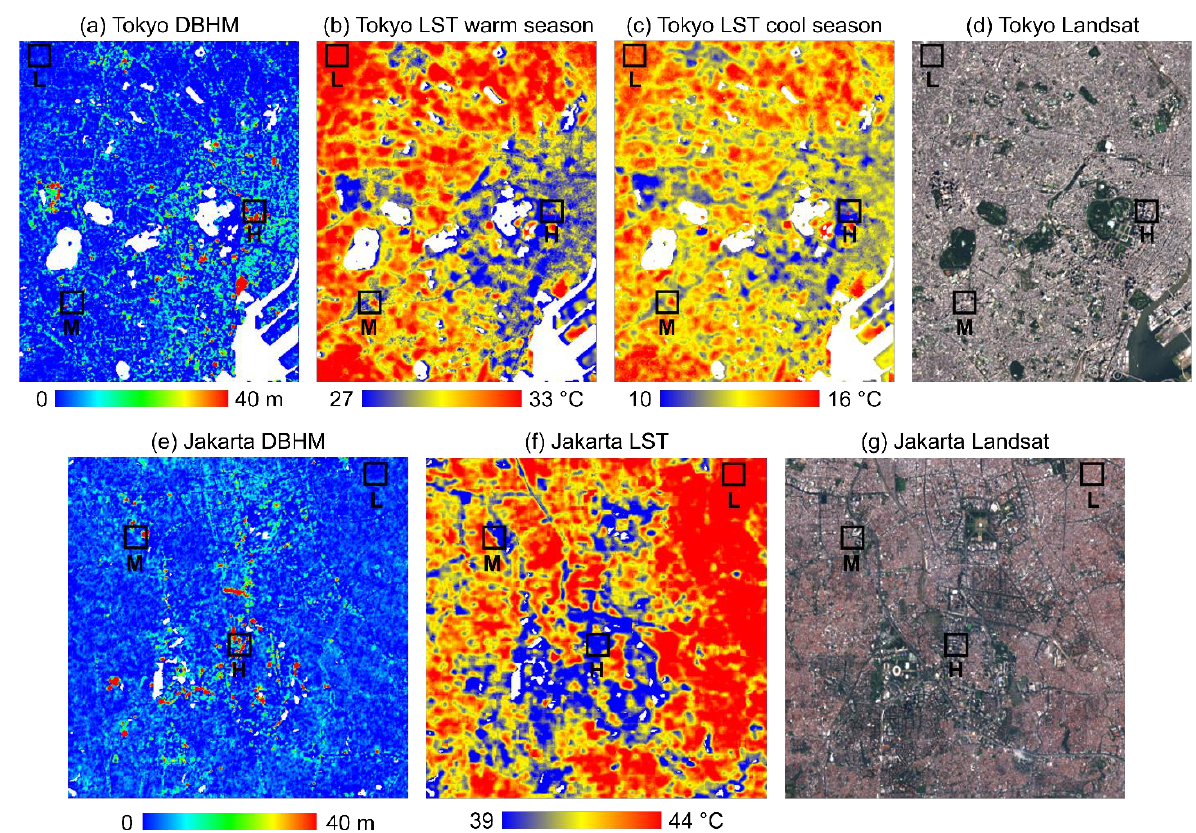
Figure 5. Results of Digital Building Height Model and Land Surface Temperature. ( a ) Tokyo DBHM, ( b ) Tokyo LST warm season, ( c ) Tokyo LST cool season, ( d ) Tokyo Landsat, ( e ) Jakarta DBHM, ( f ) Jakarta LST, and ( g ) Jakarta Landsat. Square H: high-rise building area sample, Square M: mixed height building area sample, Square L: low-rise building area sample.